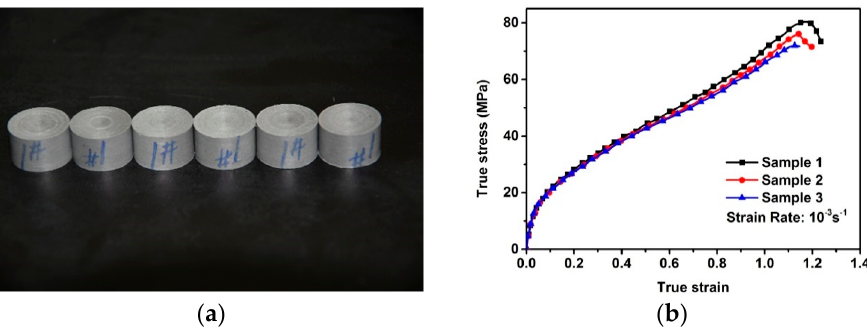
Figure 1. ( a ) Prepared Al/PTFE (polytetrafluoroethylene) samples and ( b ) true stress–strain curves of samples under quasi-static compression.